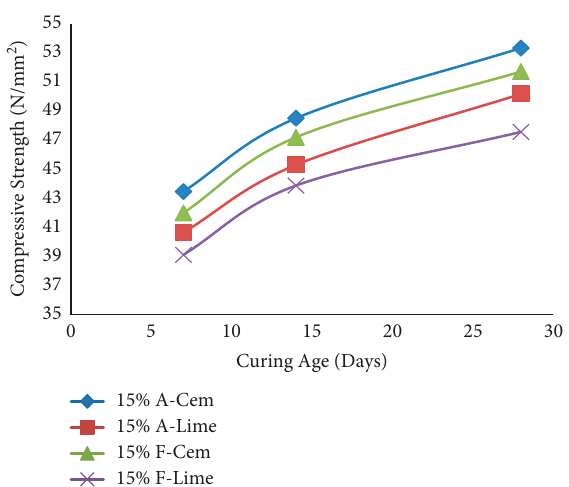
Figure 3: Compressive strength of cement and lime with 15% bagasse ash and fibre.